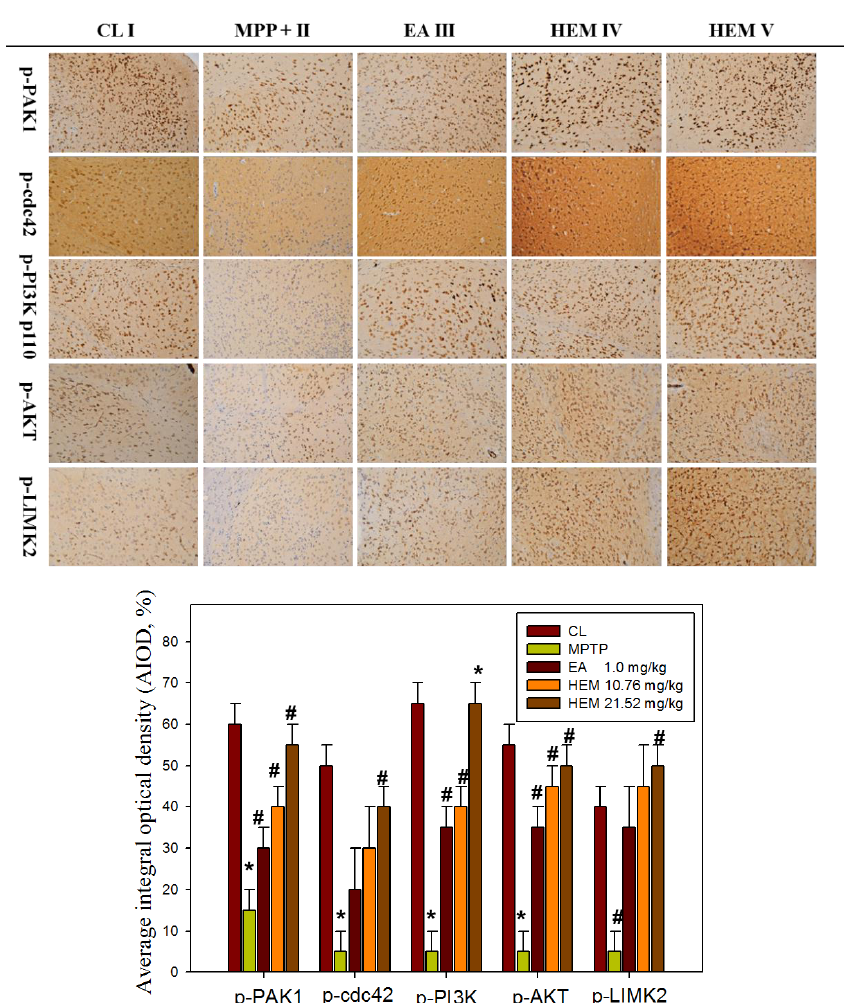
Figure 7. Post-treatment with erinacine A reversed the PAK1/AKT/LIMK2/ pathways in the MPTP-treated animals. Representative IHC images of p-PAK1, p-cdc42, p-PI3K p110, p-AKT, and p-LIMK2 in the brain region of the animals with MPP + or MPP + and erinacine A are as indicated. Quantified data of the average integral optical density are expressed as the mean ± SEM (fold increase of untreated animals). Data are expressed as mean ± S.D. (n = 6 / group); * p < 0.01, as compared to the control group; # p < 0.01, as compared to the MPP + -treated group.